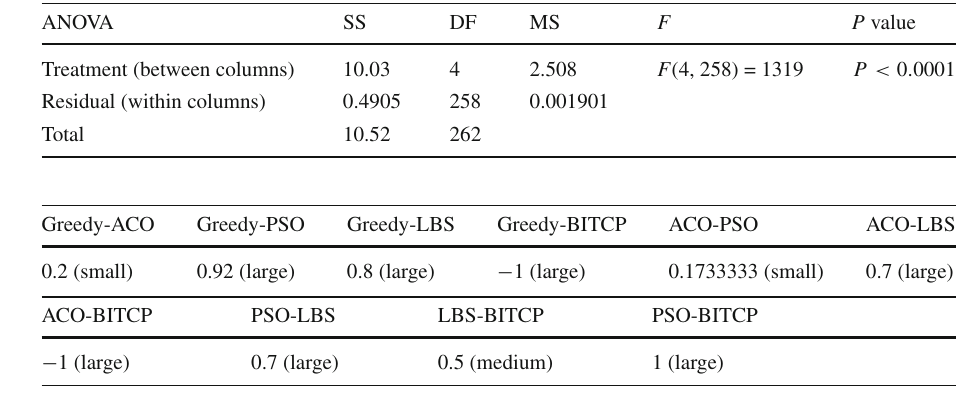
RQ5: There is a monotonic decreasing relation between two variable groups, and r s obtained from the Spearman is negative. The values generated by the algorithms, which are close to − 1, can be considered as they are devoid of resis- tance against the complexity. Figure 8 shows the relation between the complexities and detected faults of test cases.